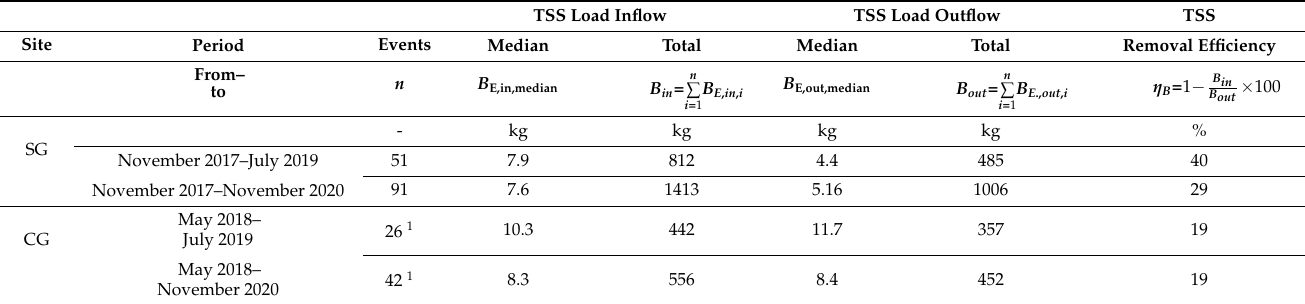
Table 4. TSS loads and removal efficiency over two monitoring periods for both DS.